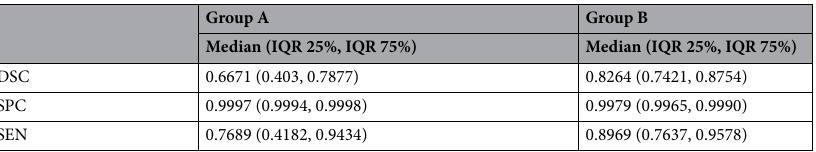
Table 3. Performance of the proposed COVID-Rate network on CT images of groups A and B. The presented results are the average of the 10-fold cross-validation.